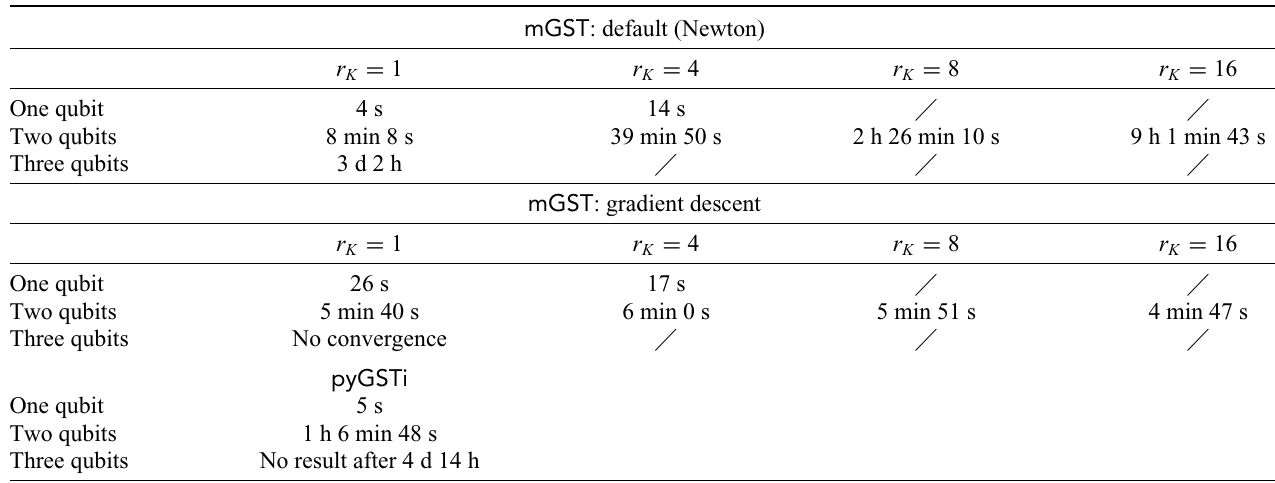
TABLE I. Average runtimes for one, two, and three qubits with selected Kraus ranks on a modern 32-core CPU. The average runtime is calculated as the average time until the first successful reconstruction with a random initialization is achieved. The one-qubit gate set is the same as in Fig. 2, the two-qubit gate set the same as in Fig. 3, and the three-qubit gate set is the same as in Fig. 4 but without using any prior knowledge. For the gradient descent method in the three-qubit scenario, no convergence is achieved within the maximum iteration limit. The average runtimes for pyGSTi are determined on the same models and with the same